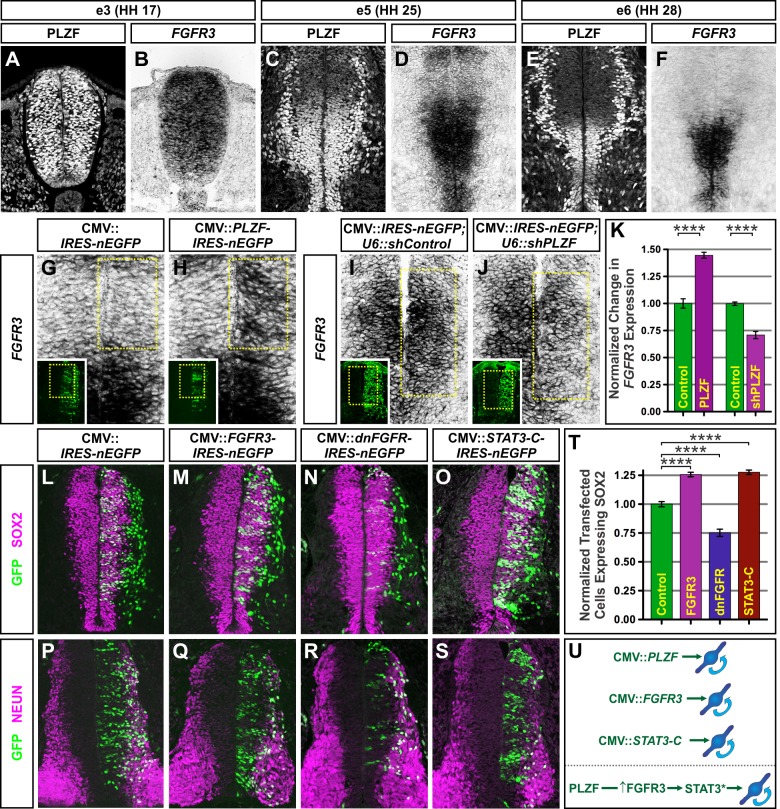
PLZF gates the abundance of FGFR3, which is critical for neural progenitor maintenance.(A–F) The pattern of PLZF expression closely matches that of FGFR3 in the developing spinal cord. (G–J) PLZF misexpression is sufficient to induce the ectopic expression of FGFR3 in the dorsal spinal cord, while PLZF knockdown reduces FGFR3 expression in the intermediate spinal cord. (K) Chart displays the mean level of FGFR3 mRNA ± SEM in spinal cords electroporated with the indicated constructs relative to the contralateral control sides. (L–M, O–Q, S–T) NPCs transfected with either FGFR3 or STAT3-C expression plasmids display an increased propensity for SOX2 expression and reduced expression of NEUN. (N, R) Disruption of endogenous FGFR3 function through the expression of a dominant negative FGFR promotes the formation of NEUN+ neurons. (T) Chart displays the mean number of cells expressing SOX2 ± SEM among the indicated experimental conditions, relative to empty vector controls. All electroporations except those shown in (I–K) were performed at e3 (HH 17) and collected at e5 (HH 25). Embryos in (I–K) were electroporated at e2 (HH 10) and collected at e4 (HH 21). Counts were based on at least 12 images taken from ≥8 electroporated embryos. ****p<0.0001. (U) Summary of results highlighting the similarities of PLZF, FGFR3, and STAT3-C misexpression on neural progenitor maintenance, and their presumed hierarchical relationship. PLZF repressor function (solid line) indirectly elevates FGFR3 expression levels, resulting in increased activation of STAT3 (STAT3*) and enhanced progenitor maintenance.